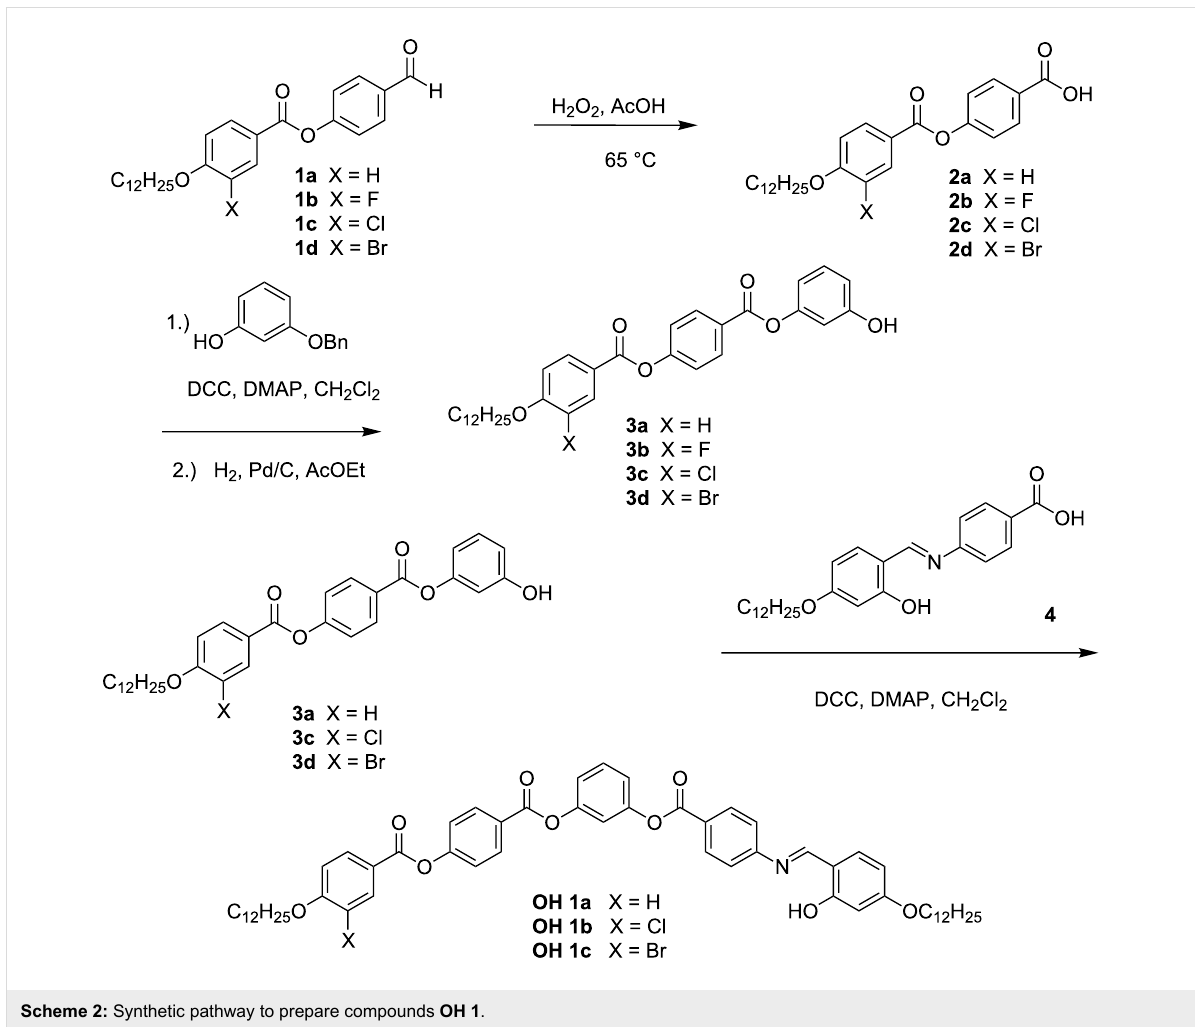
Table 1: Mesophase behaviour, transition temperatures (°C) and enthalpies [kJ/mol], and P S values (nC/cm 2 ) of compounds OH 1 and H 1a .